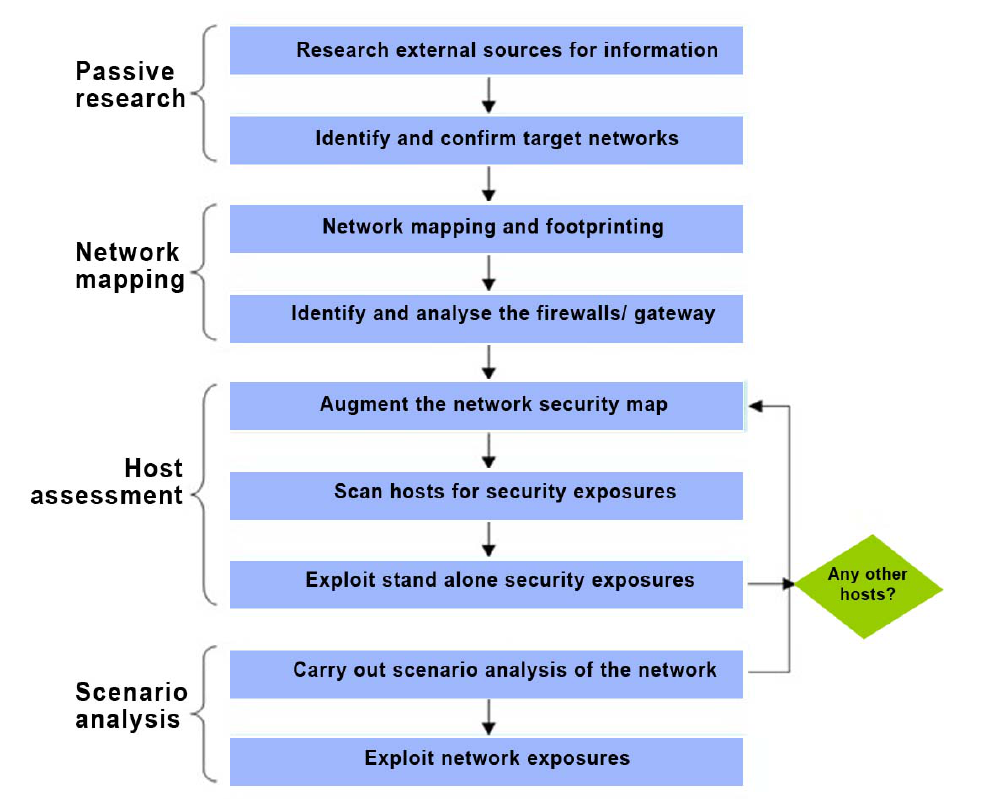
Figure 3. Penetration Testing.